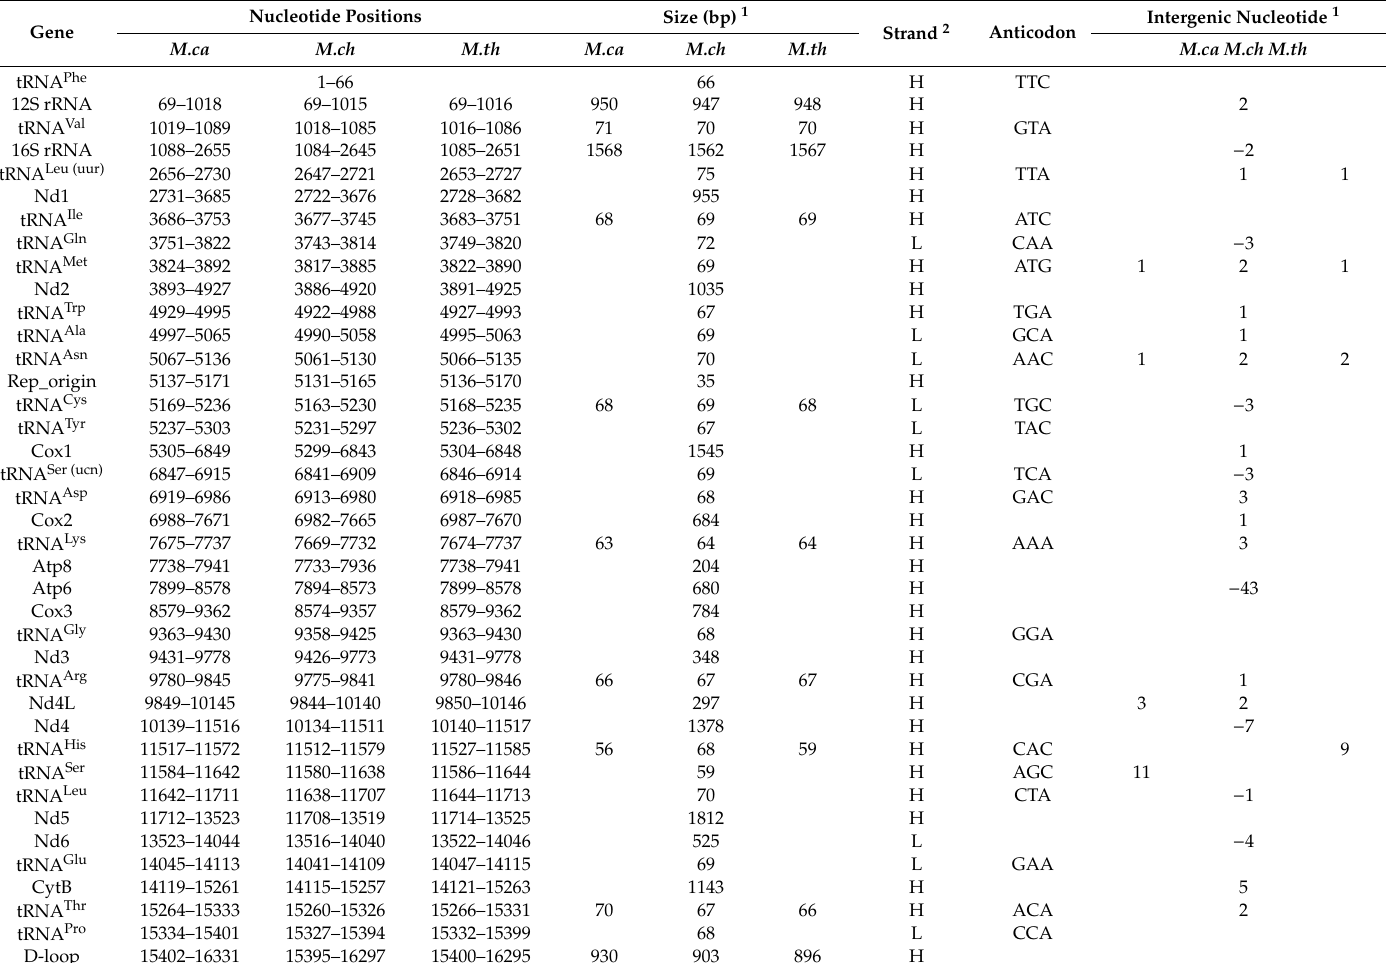
Table 1. Gene organization of the three Microtus mitogenomes ( M.ca : M. cabrerae ; M.ch : M. chrotorrhinus ; M.th : M. thomasi